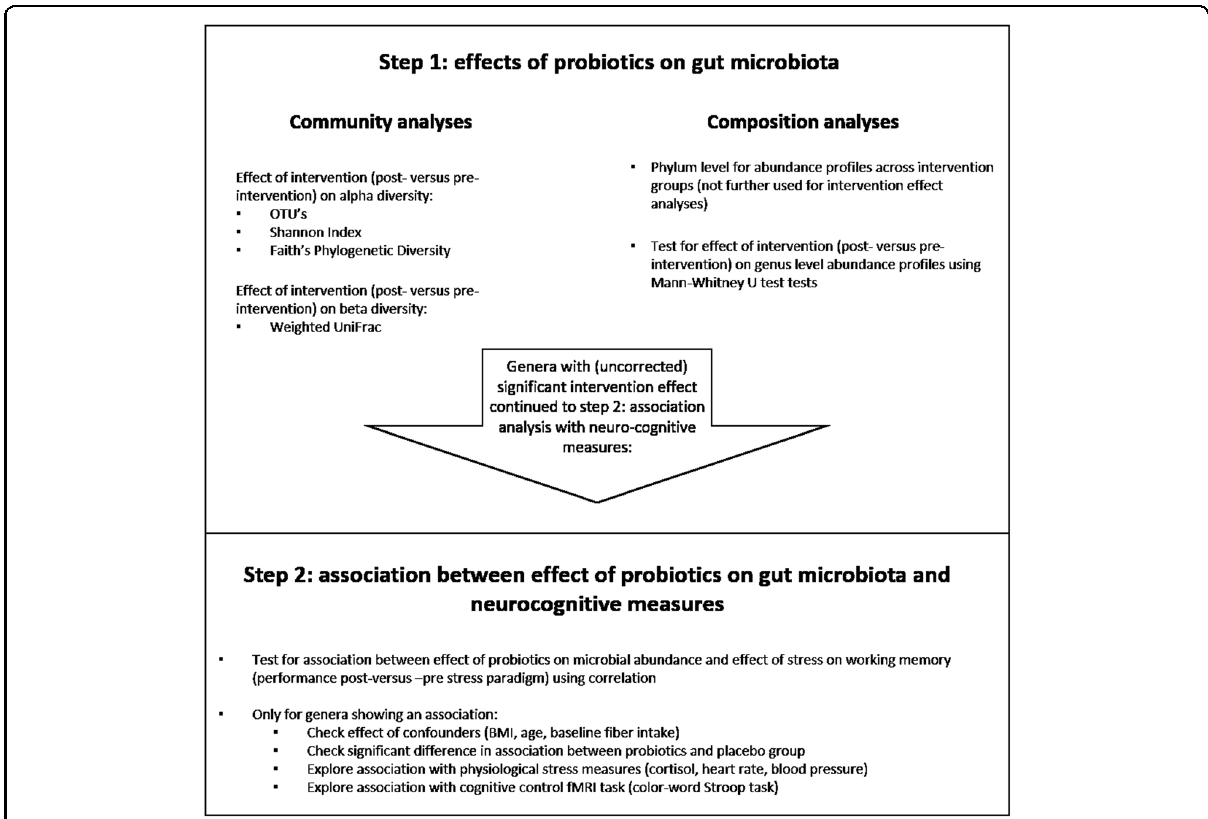
Fig. 2 Analysis fl ow chart. In a fi rst step, community dynamics were compared between intervention (post-intervention versus pre-intervention) groups, and the composition of the two intervention groups was compared at the genus level. Secondly, the results of step 1 were used as a selection criterium to associate gut microbial candidates with neuro-cognitive